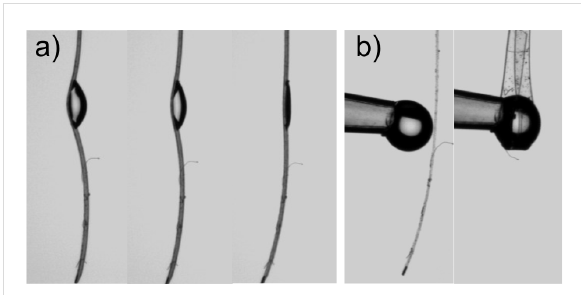
Figure 2: Effect of droplets of water on a thin polydimethylsiloxane (PDMS) membrane ribbon substrate hanging vertically: a) droplet causing a bending of the substrate which disappears as evaporation proceeds (three frames), b) spontaneous wrapping as a droplet touches a membrane ribbon (initial and final states).